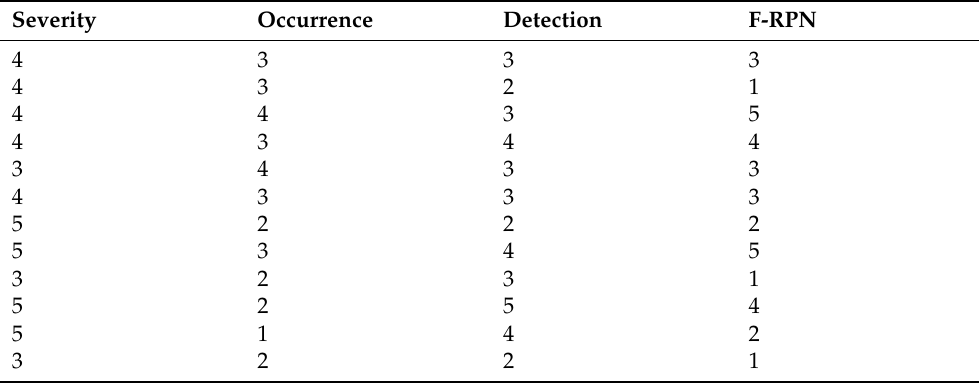
Table 5. The combination of this FMEA fuzzy rule base.